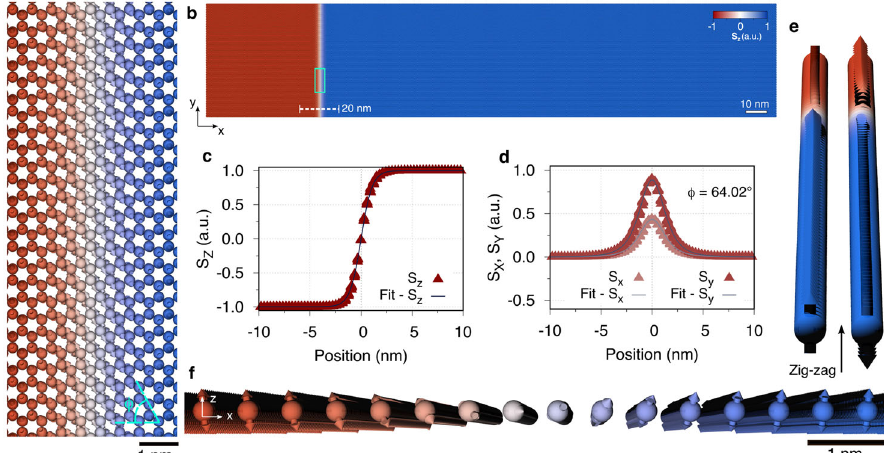
Fig. 2 Hybrid domain wall formation and spin rotation. a , b Local and global view, respectively, of a snapshot of one of the spin con fi gurations in a 300 nm × 50 nm ribbon of MnPS 3 . The small rectangle in b corresponds to area studied in a . The out-of-plane component of the magnetization S z (color map) is utilized to monitor the formation of the domain wall. Spins rotated across the wall in pairs forming an angle ϕ with the zig-zag crystallographic direction of the honeycomb lattice of 64.02 o . The system is at zero magnetic fi eld and 0 K. c , d Pro fi le of the magnetization along the domain wall projected along S z and the in-plane (S x , S y ) components, respectively. Fitting curves are obtained using Eqs. (1) and (2). We computed domain wall widths σ z = 3.41 nm (±0.03) and σ x , y = 3.50 nm (±0.06). e , f Top and side views, respectively, of the rotation of the magnetization along the domain wall. Both S x and S y show variations along the wall altogether with S z which indicate a hybrid character of the domain wall, i.e., neither Bloch nor N& eel. Colors follow the scale bar in b